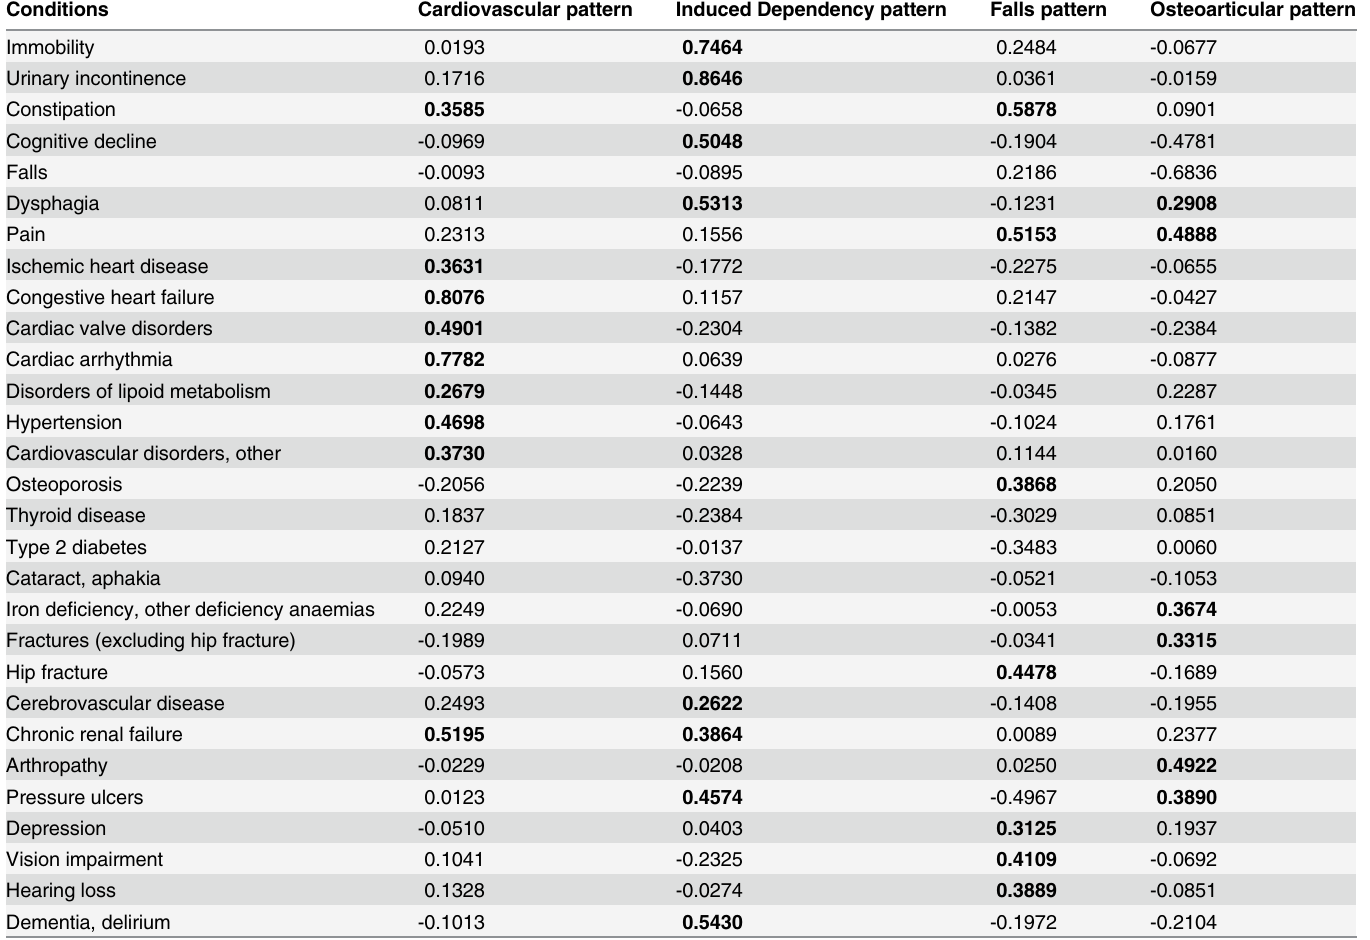
Table 4. Factor scores of the conditions included in each pattern in women. KMO: 0.55. Percentage of cumulative variance: 35.32%. Factor scores > 0.25 are highlighted in